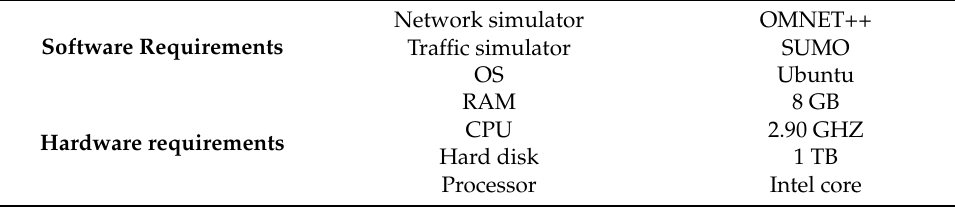
Table 5. System requirements.